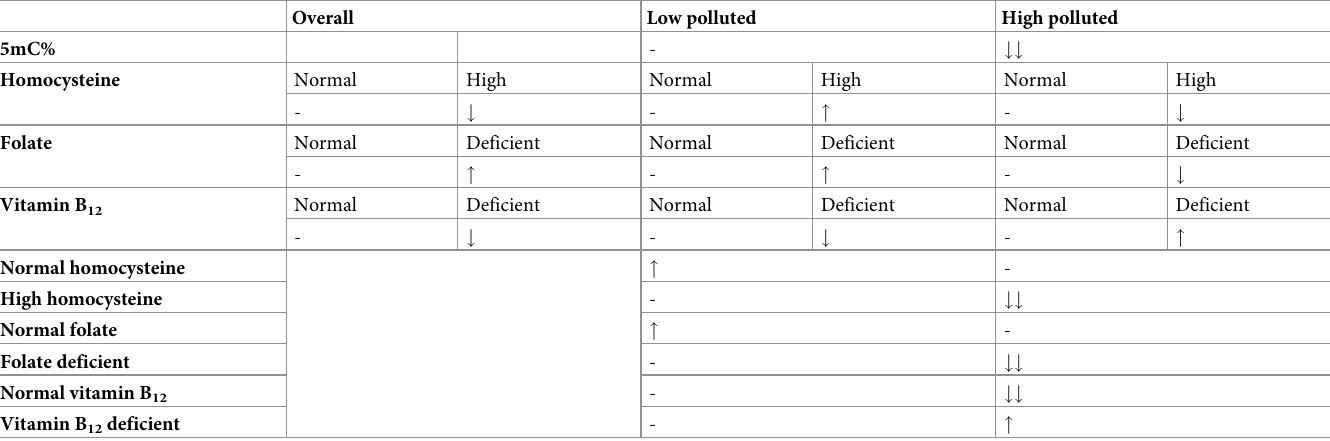
Table 6. Summary comparison of methylation levels in the present